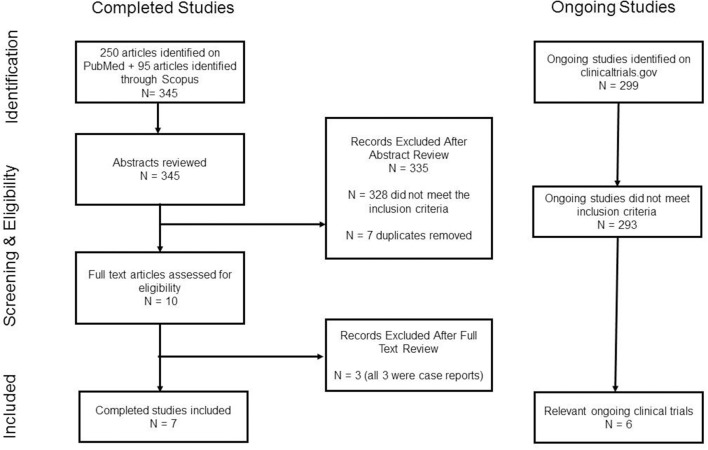
Study flow diagram.